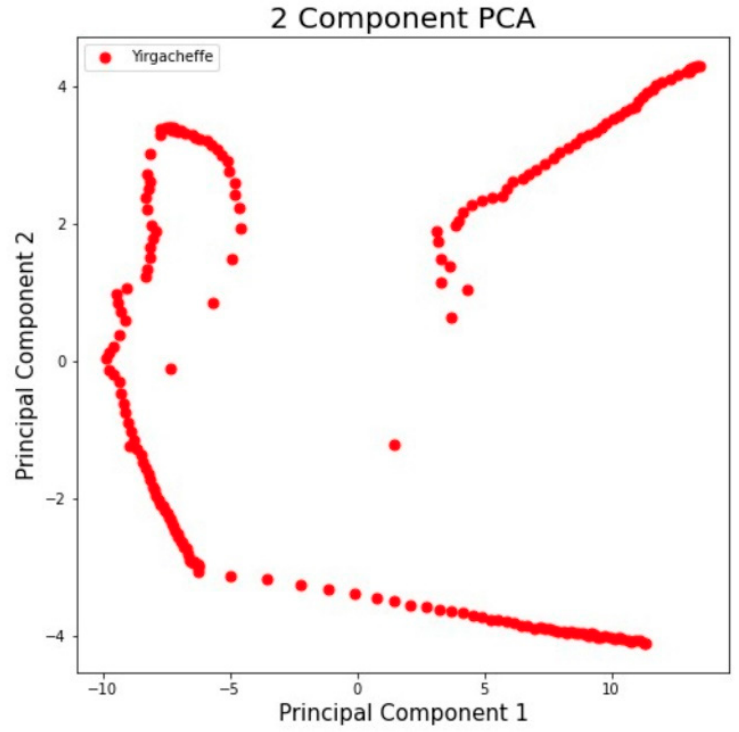
Figure 5. A sample digital fingerprint of coffee aroma.